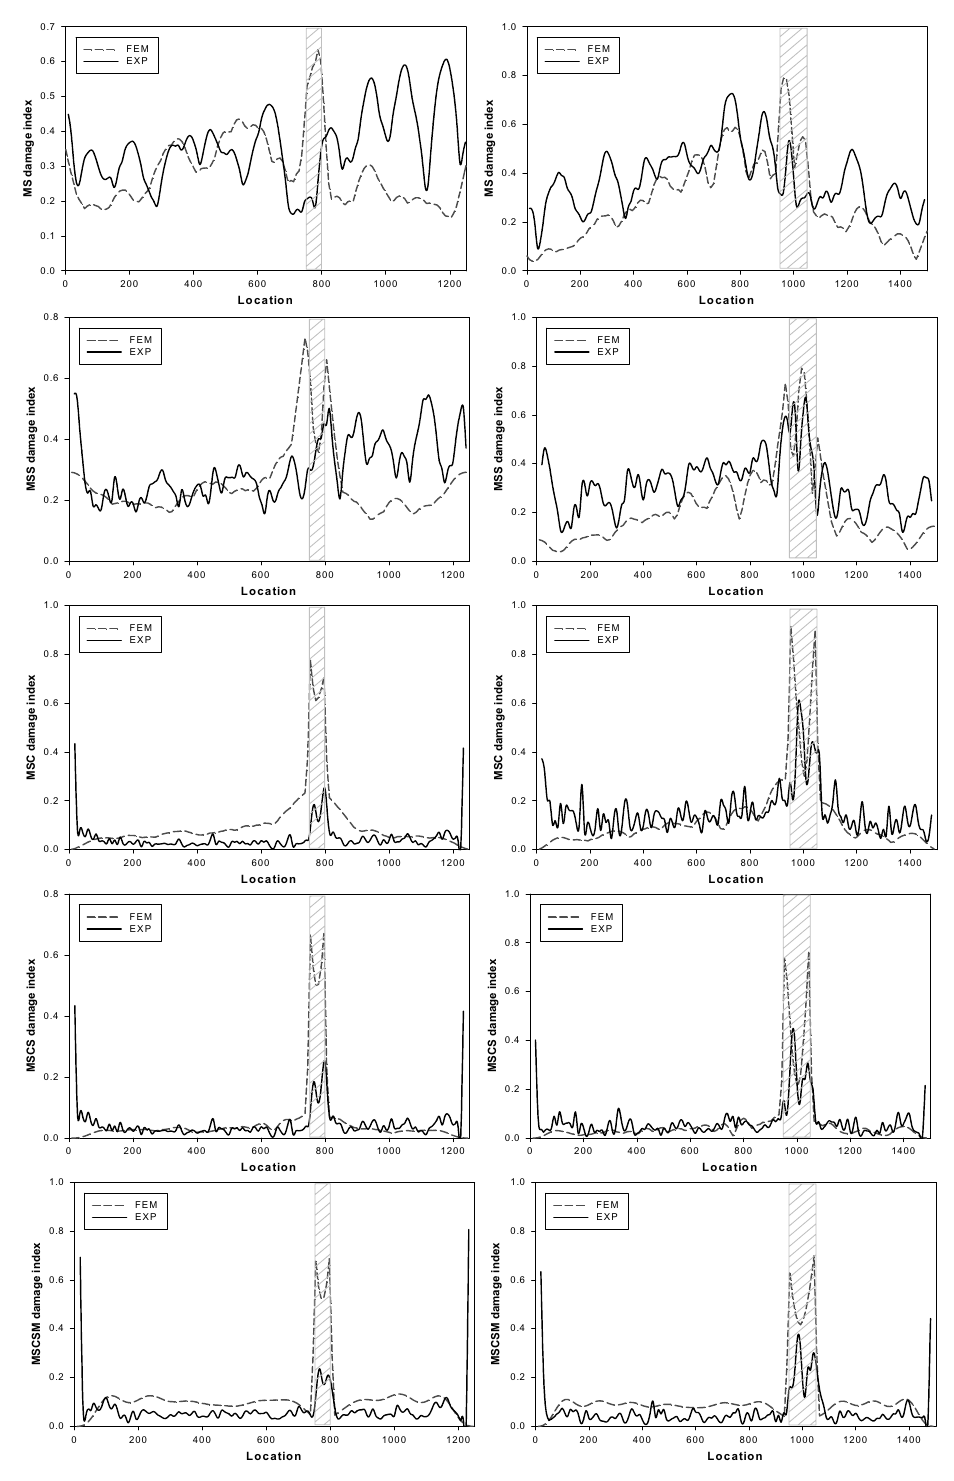
Fig. 3. Damage detection methods for beams with FF boundary conditions; Beam1 – left; Beam 2 –